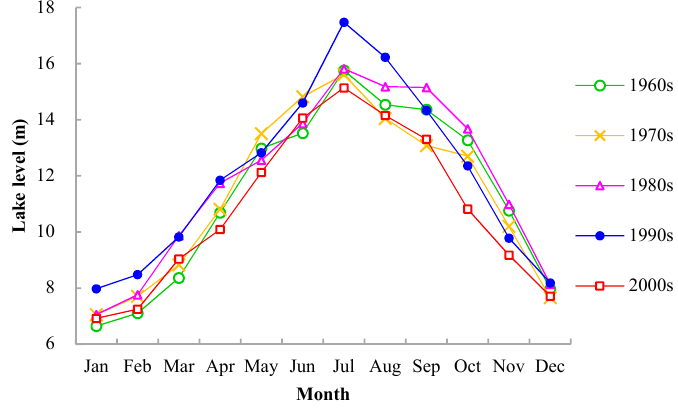
Figure 3. Inner-annual variations in lake level at Xingzi station.